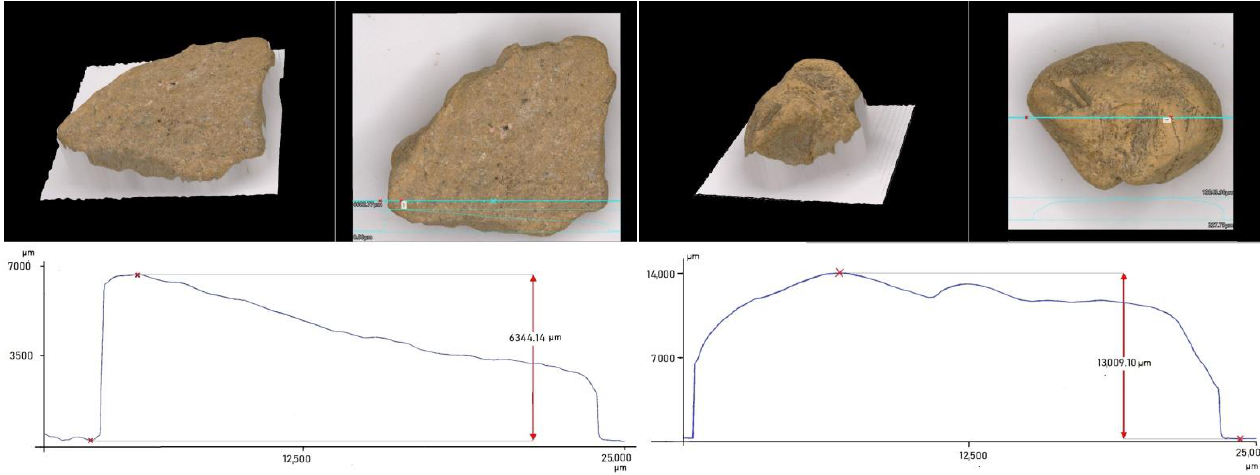
Figure 10. Exemplary analysis of irregular ( left ) and regular ( right ) particle in 3D Keyence VHX-7000 microscope. Table 9. Results of Los Angeles and micro-Deval indices for a gravel aggregate in particle size fraction 10–14 mm at different stages of